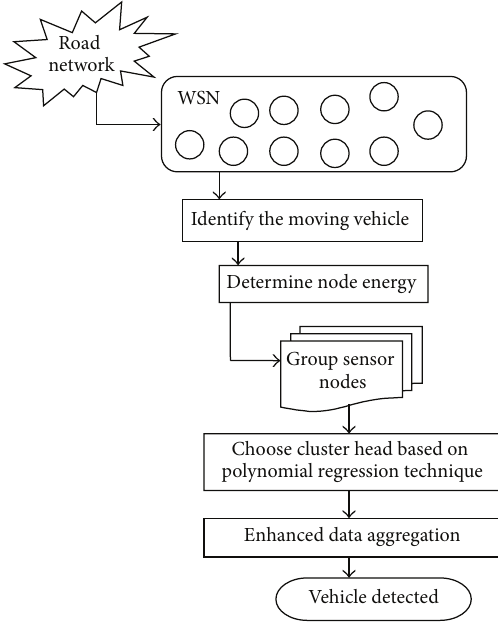
Figure 1: Architecture diagram of